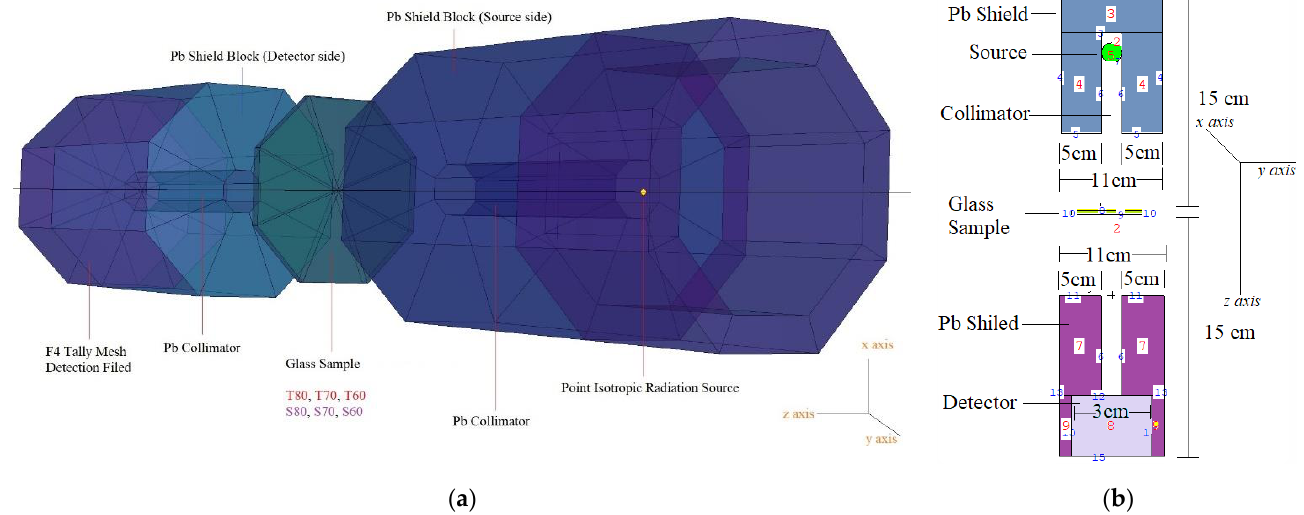
Figure 1. MCNPX simulation setup used for gamma-ray transmission simulations ( a ) direct screenshot from the MCNPX Visual Editor VE X_22S. ( b ) 2D view of simulation setup obtained from MCNPX visual editor.